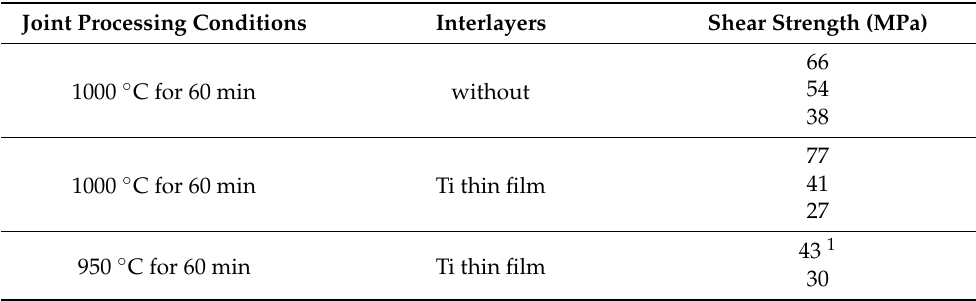
Table 2. Shear strength values of the joints produced without interlayer at 1000 ◦ C for 60 min and with Ti thin film at 1000 and 950 ◦ C for 60